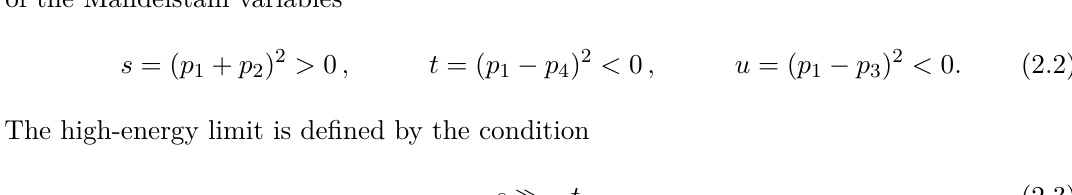
Figure 1. 2 to 2 particle scattering corresponding to eq. (2.1). The two partons i and j can be quarks or gluons, and the arrows indicate the direction of the momenta. The indices a indices, while the labels λ represent the particle helicities. At leading power in the high-energy k limit the amplitude is helicity conserving, as indicated at tree level in eq.